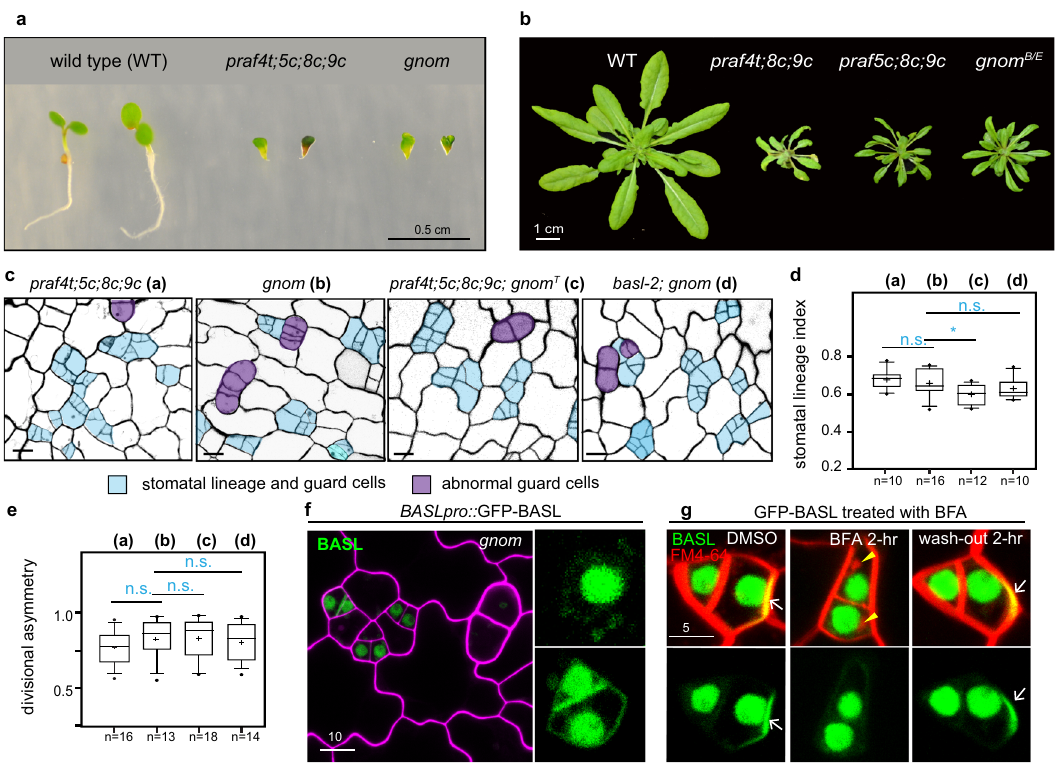
Fig. 5 gnom mutants highly resemble praf mutants. a 4-day-old seedlings of wild type, praf4t;5c;8c;9c , and loss-of-function gnom (segregated from gnom B/E ) mutants. b 4-week-old plants of wild type, praf triple mutants ( praf4t;8c;9c and praf5c;8c;9c ), and gnom B/E (trans-heterozygously complementing B4049 and emb30-1 alleles). c Confocal images show stomatal phenotypes of 5-day-old adaxial cotyledon epidermis of the designated genotypes. Stomatal lineage and guard cells are manually traced and highlighted. Three independent experiments were performed. Scale bar = 10 μ m. d Box plots show quanti fi cation of stomata lineage index for ( c ). Box plots show fi rst and third quartile (box), median (line) and mean (cross). n , # cotyledons counted. Student ’ s unpaired t tests were used for comparison. Two-sided P values are 0.4439 (for gnom vs. praf4t;5c;8c;9c ), 0.0258 (for gnom vs. gnom ; praf4t;5c;8c;9c ), and 0.2922 (for basl-2;gnom vs. gnom ). n.s. not signi fi cant; * P <0.05. e Box plots show quanti fi cation of divisional asymmetry in the stomatal lineage for ( c ). Box plots show fi rst and third quartile (box), median (line) and mean (cross). n , # daughter cell pairs. Student ’ s unpaired t tests were used for comparison. Two-sided P values are 0.1707 (for gnom vs. praf4t;5c;8c;9c ), 0.9274 (for gnom vs. gnom ; praf4t;5c;8c;9c ), and 0.6190 (for basl-2;gnom vs. gnom ). n.s., not signi fi cant. f GFP-BASL (green) lost polarization in gnom . Magenta, cell outlines stained by PI. Data represent the results of three independent experiments. g Confocal images show GFP-BASL (green) merged with 8 μ M FM4-64 staining (red) (top) or GFP-channel only (bottom). Three-day old seedlings were pre-incubated with FM4-64 for 40-min (left), then treated with 70 μ M BFA for 2h (middle), followed by 2h wash-out (right). Yellow arrowheads indicate BFA-induced endomembrane aggregations. White arrows, protein polarization. Note no BASL polarization observed after BFA treatment (middle). Three independent experiments were performed. Scale bar, 5 μ